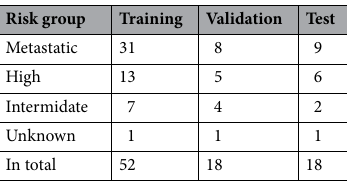
Table 1. Patient split of training, validation, and test sets on NCCN risk groups.